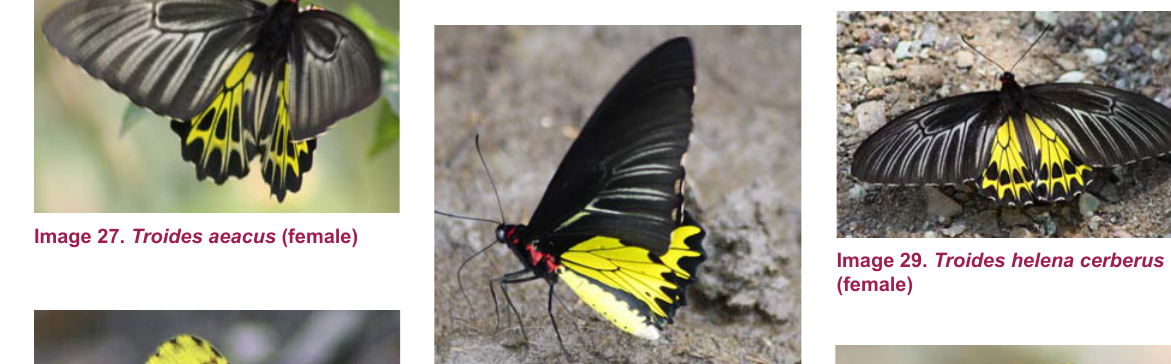
Image 28. Troides helena cerberus (male)